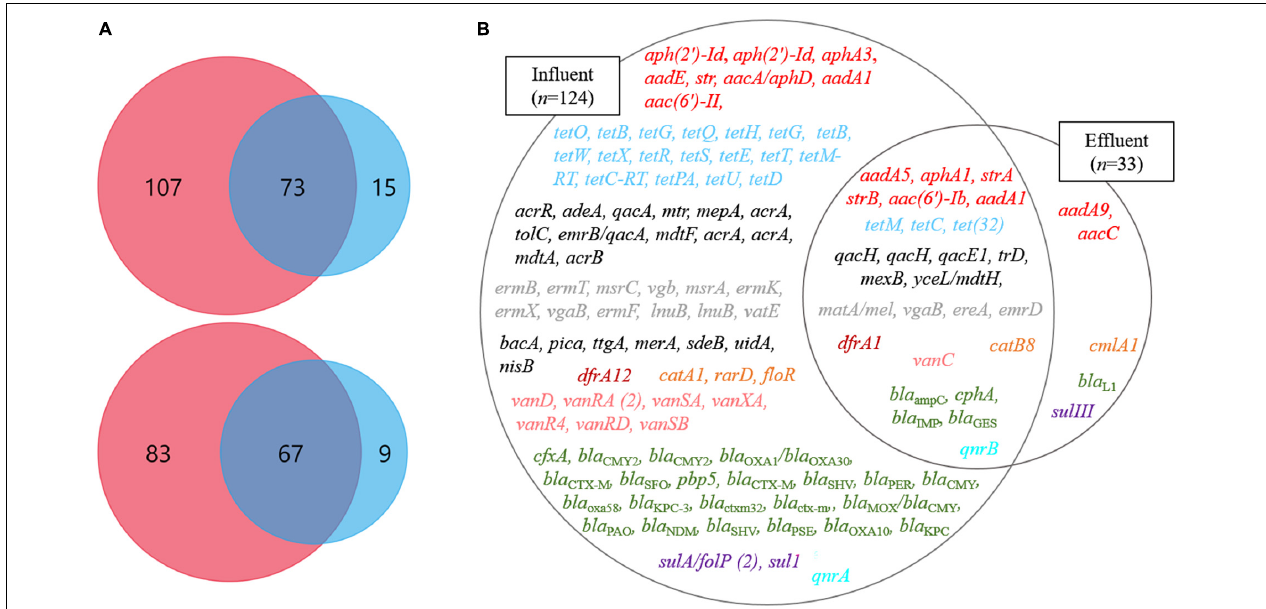
FIGURE 4 | The ARGs at influents (Inf) and effluents (Ef) of wastewater treatment plants through SmartChip analyses. (A) The Venn diagrams represent the shared ARGs between influents (pink) and effluents (blue) in 2017 (top) and 2018 (bottom). (B) The Venn diagram on the right side represents the core ARGs between influents (left circle) and effluents (right circle). Each color indicates a class of ARGs as red (aminoglycoside), sky-blue (tetracycline), gray (macrolide), black (miscellaneous), brown (trimethoprim), orange (Amphenicol), green ( β -lactam), purple (sulfonamide), pink (glycopeptide), and mint